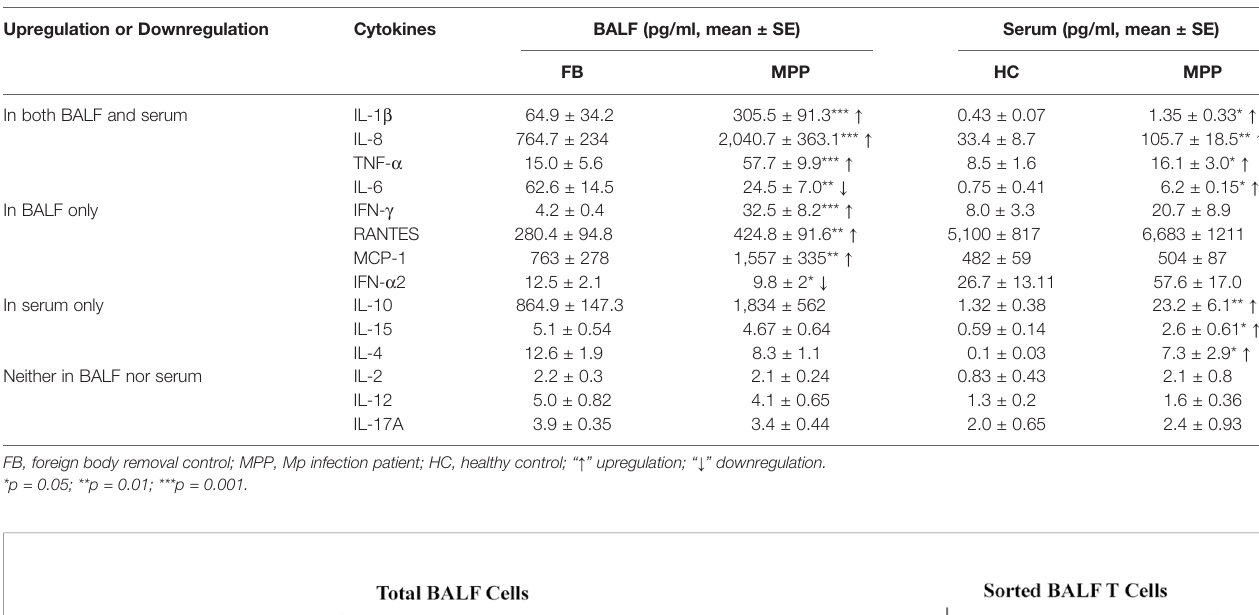
In both BALF and serum